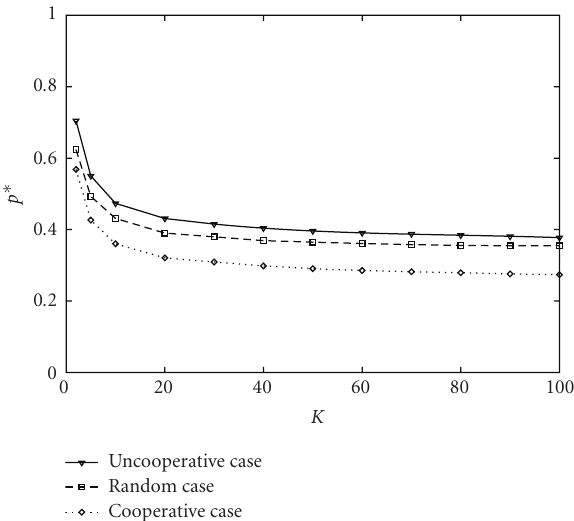
Figure 12: File availability p ∗ as a function of K (scale-free network with m = 2, strategy assignment